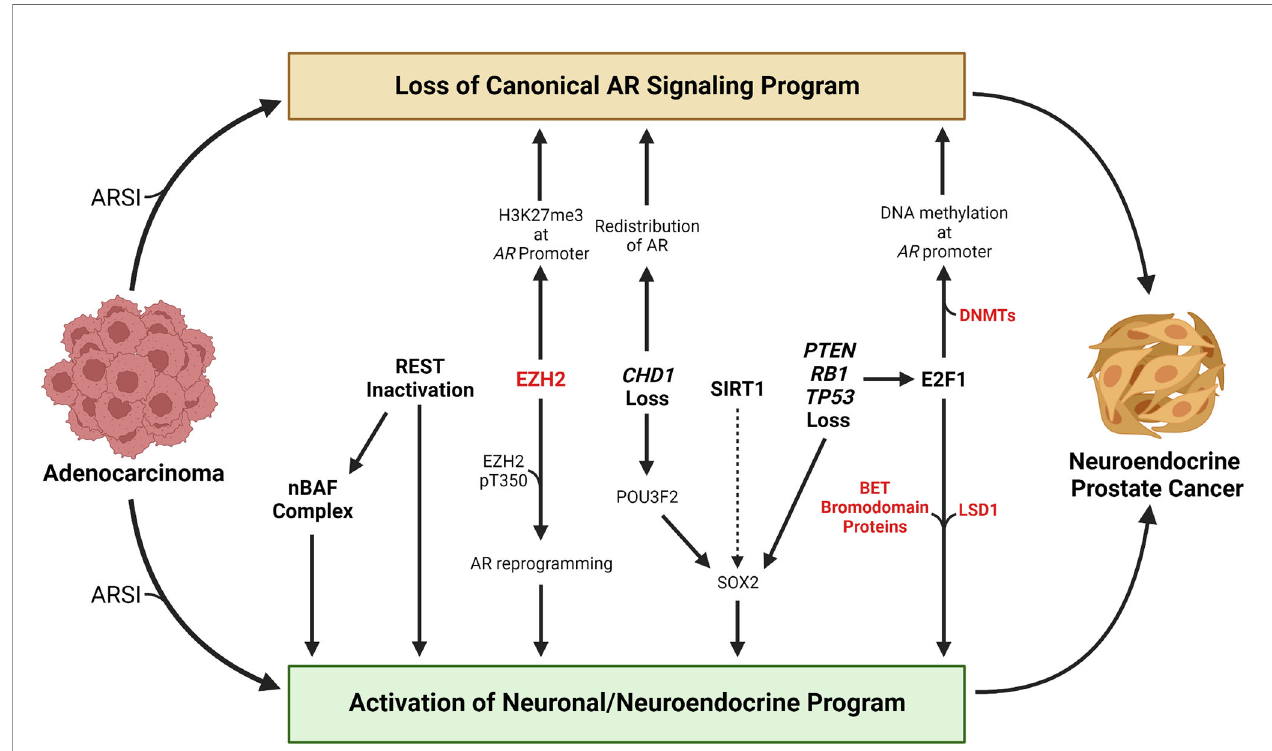
FIGURE 1 | Overview of selected molecular events that contribute to the transition from adenocarcinoma to neuroendocrine prostate cancer. Loss of a canonical AR signaling program and activation of a neuronal or neuroendocrine program are hallmarks of the transition from adenocarcinoma to neuroendocrine prostate cancer. Treatment with AR signaling inhibitors (ARSIs) results in suppression of canonical AR signaling and activation of AR-repressed genes linked with a neuronal or neuroendocrine program in some tumors. Loss of REST ’ s repressive activity promotes NEPC lineage plasticity, in part through activation of the nBAF chromatin remodeling complex. EZH2 has been shown to silence AR expression by catalyzing H3K27me3 at the AR promoter. Phosphorylation of the T350 residue on EZH2 results in reprograming of the AR cistrome and activation of stemness or neuronal genes. Loss of the chromatin remodeling factor CHD1 results in redistribution of the AR away from canonical AR target genes to tumor-speci fi c AR-bound regions. CHD1 loss also increases chromatin accessibility for the neuronal transcription factor POU3F2 that may contribute to activation of the stemness factor SOX2. The HDAC SIRT1 promotes NEPC lineage plasticity, potentially through activation of SOX2. PTEN, RB1 , and TP53 are commonly altered in NEPC, and their loss promotes activation of a neuronal program in part through activation of E2F1 or SOX2. E2F1 has been shown to cooperate with DNA methyltransferases to silence the AR through AR promoter DNA methylation. E2F1 also cooperates with LSD1 or BET bromodomain chromatin readers to activate a cell cycle or neuronal program. Factors that are currently targetable with drugs that are approved by the Food & Drug Administration or that are in clinical trials are shown in red. Created with